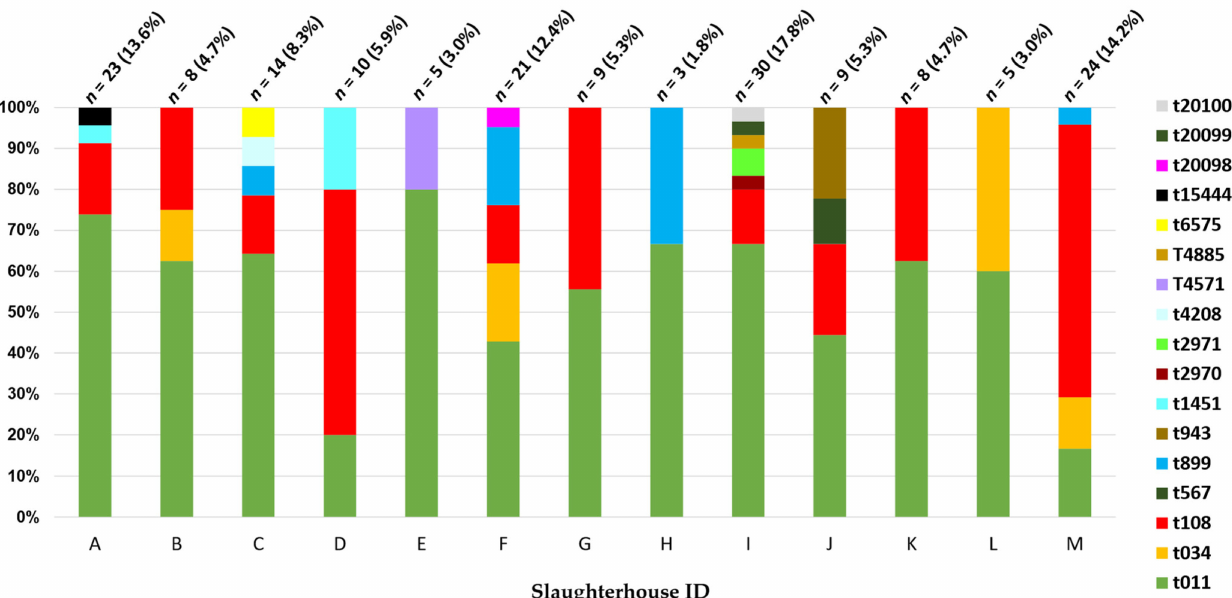
Figure 3. Distribution of spa -types among the MRSA groups isolated from samples collected from the 13 slaughterhouses ( n = 169). Each bar represents the spa -types obtained from a slaughterhouse. The number and the percentage of isolates are shown for each